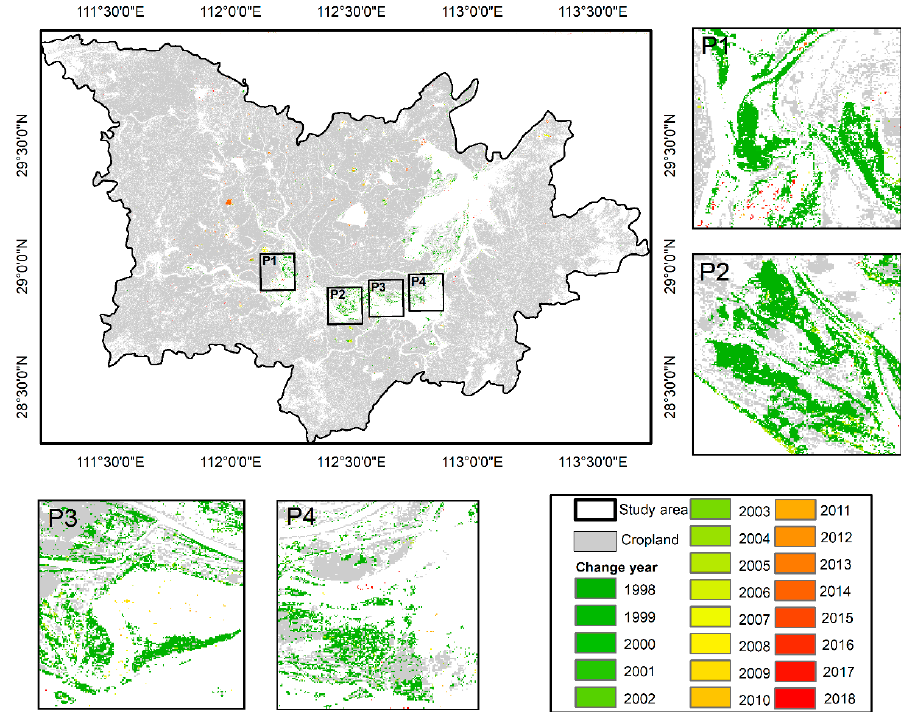
Figure 7. Year of conversion from cropland to poplar cultivation with four areas shown in detail: